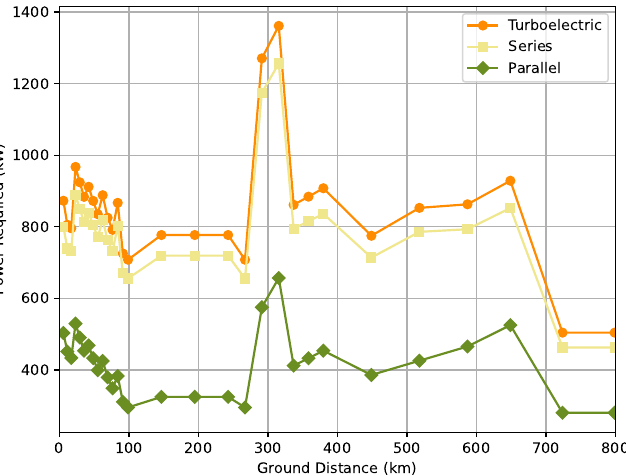
Figure 12. Comparison of the power required to the turboshaft between the two configurations. A linear correlation was noted between the power required for the turboshaft and fuel consumption, and given that, the same comments made for power can be made for the fuel flow, as seen in Figure 13: although the series hybrid-electric system is more efficient than the turboelectric one, it is less efficient than the parallel hybrid system, assuming the same hybridization factor and disregarding the usable payload.